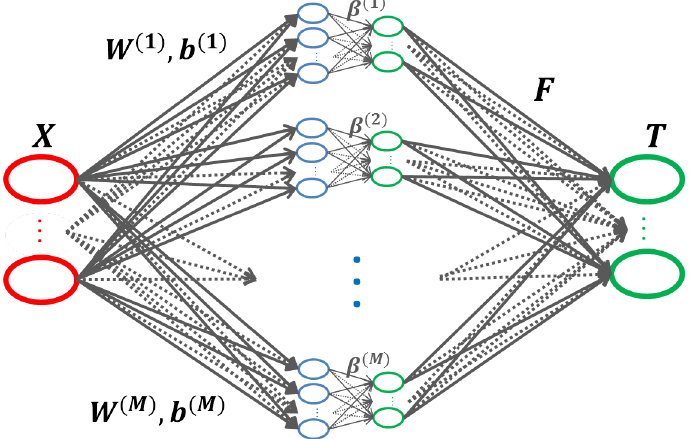
Figure 2. The proposed ELM based ensemble can be seen as a two hidden layers neural networks, trained using the ELM